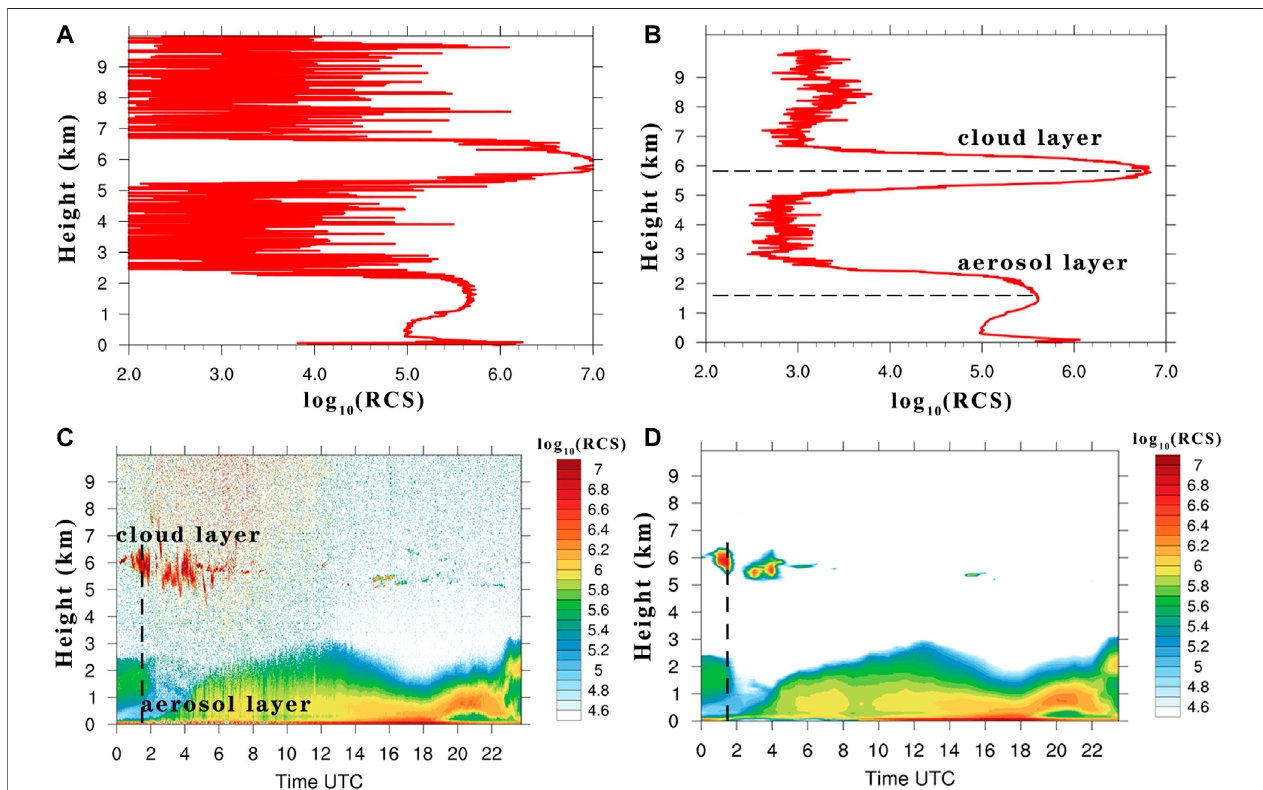
FIGURE 5 | Normalized range-corrected signal in logarithmic scale [log 10 (RCS)] of the ceilometer at 01:30 UTC on August 14, 2019. (A) Raw signals with 5-m vertical resolution and 15-s interval. (B) Smoothed signals with 15-m vertical resolution and 30-min time interval. Time evolutions of log 10 (RCS) of the ceilometer on August 14, 2019. (C) Rawsignals. (D) Smoothed signals.Theblackdashed linedenotes thecorrespondingtime oflog 10 (RCS) in Figures4A, B .There isadistinct dust aerosol layer from the surface to 2 km in height, and a visible cloud layer appears at a height of 5 – 6.5 km.